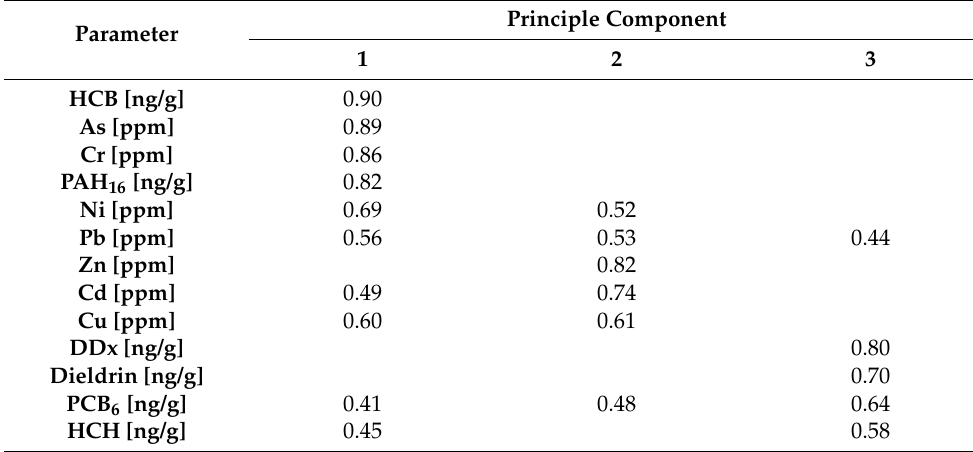
Table 9. Correlation coefficients between organic and inorganic pollutants in the humus layer and the first three factors resulting from principle component analysis after Varimax rotation with Kaiser normalization (NFSI-2, n =